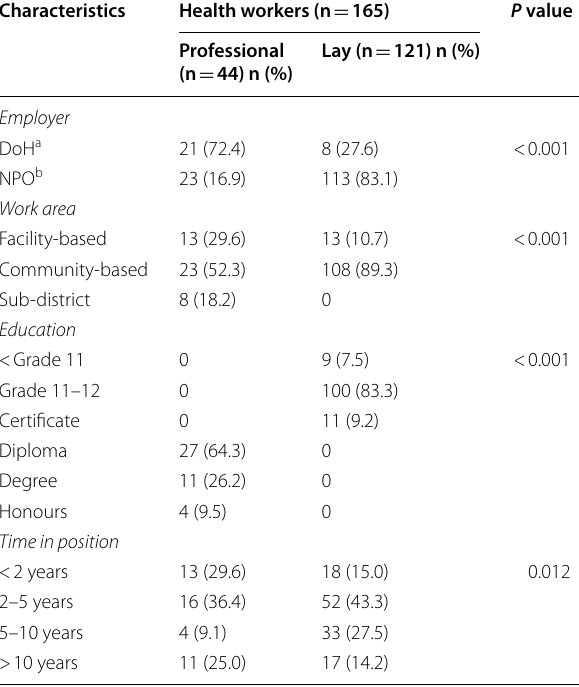
Table 3 Demographic characteristics of survey participants Table 4 Occupational characteristics of health